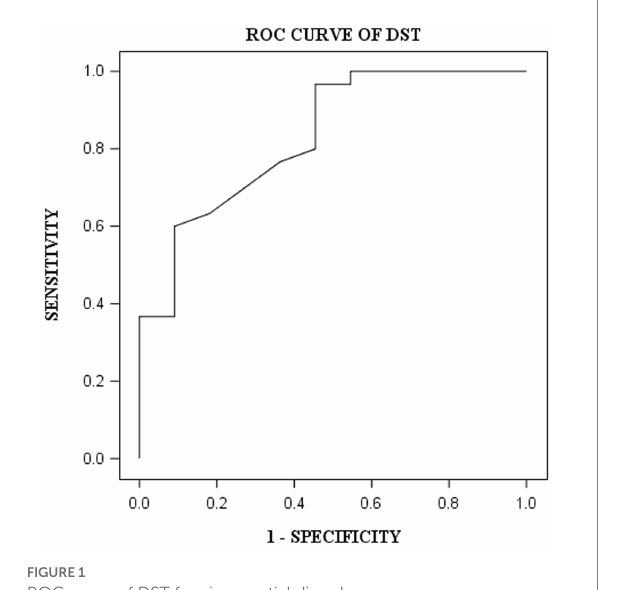
FIGURE 2 ROC curve of VOT for visuospatial